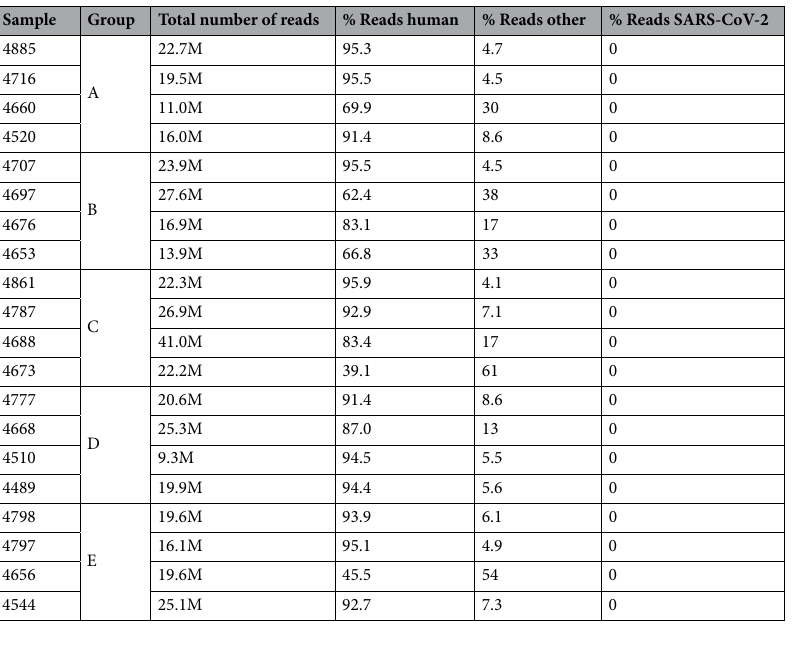
Table 2. Summary of the results of metagenomic sequencing of pre-capture libraries sequenced on the NextSeq 500 in high-output mode. Percentages represent the percentage of assignation using k-mer analysis with Kraken2 software. Other: virus + bacteria + unclassified.